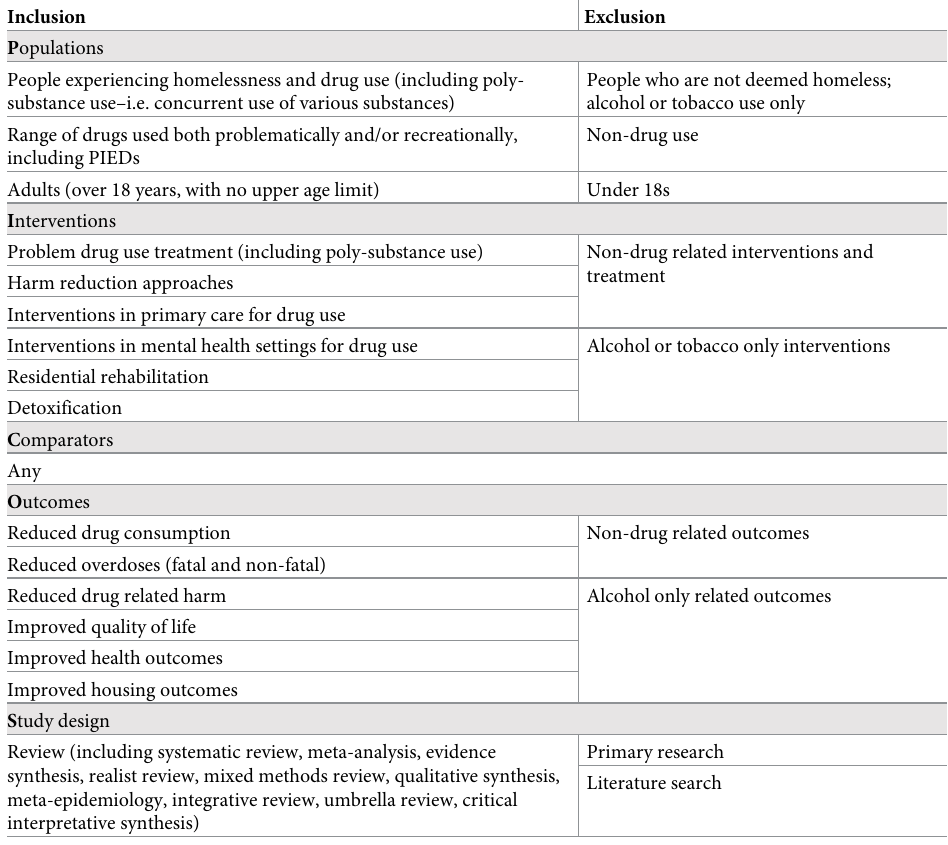
Table 1. Inclusion/exclusion